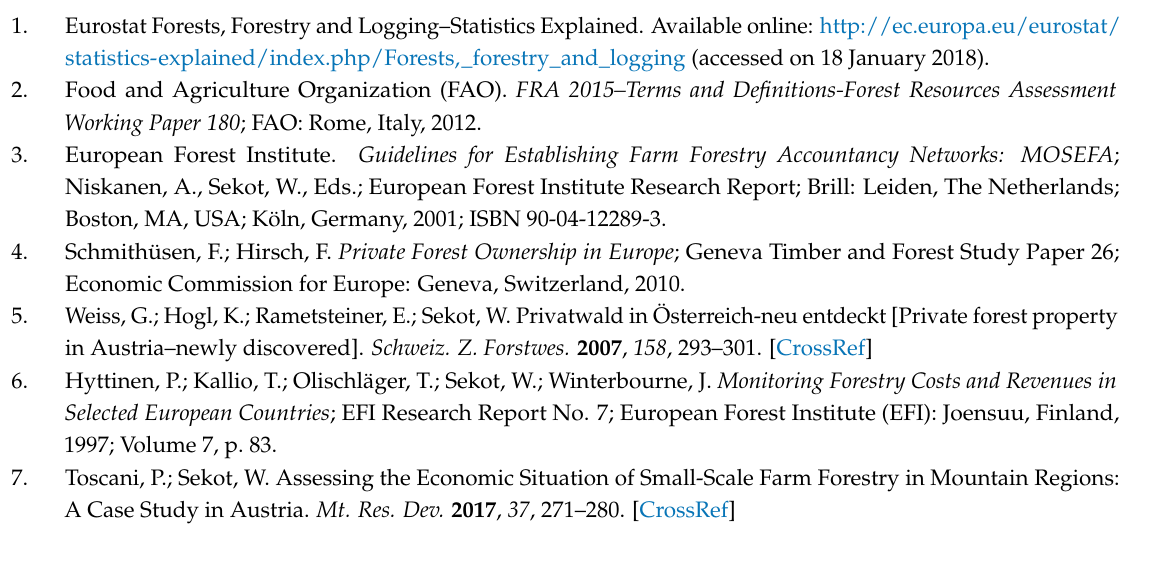
Table S1: Sources found and selection process of the systematical literature review. Titles in brackets [] contain the original translation of the title and indicate the availability of at least an English abstract. PS . . . Primary search result; EP . . . Excluded records from primary search; SS . . . Secondary search result; ES . . . Excluded records from secondary search; FA . . . Full-text articles assessed for eligibility; IQ . . . Publications included in the qualitative synthesis; CI . . . Citation, Table S2: Identified European FAN including additional information about the operator and or links to recent publications of